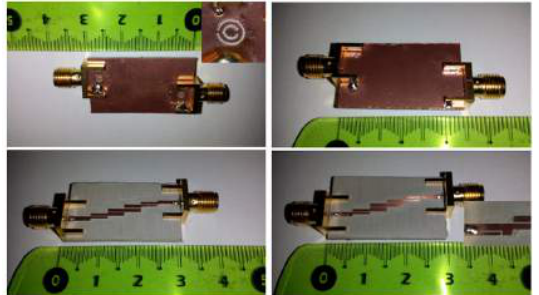
Figure 5: Photograph of the proposed filters : Top and bu- tom layers with CSRRs (left), Top and butom layers with Slots(right)